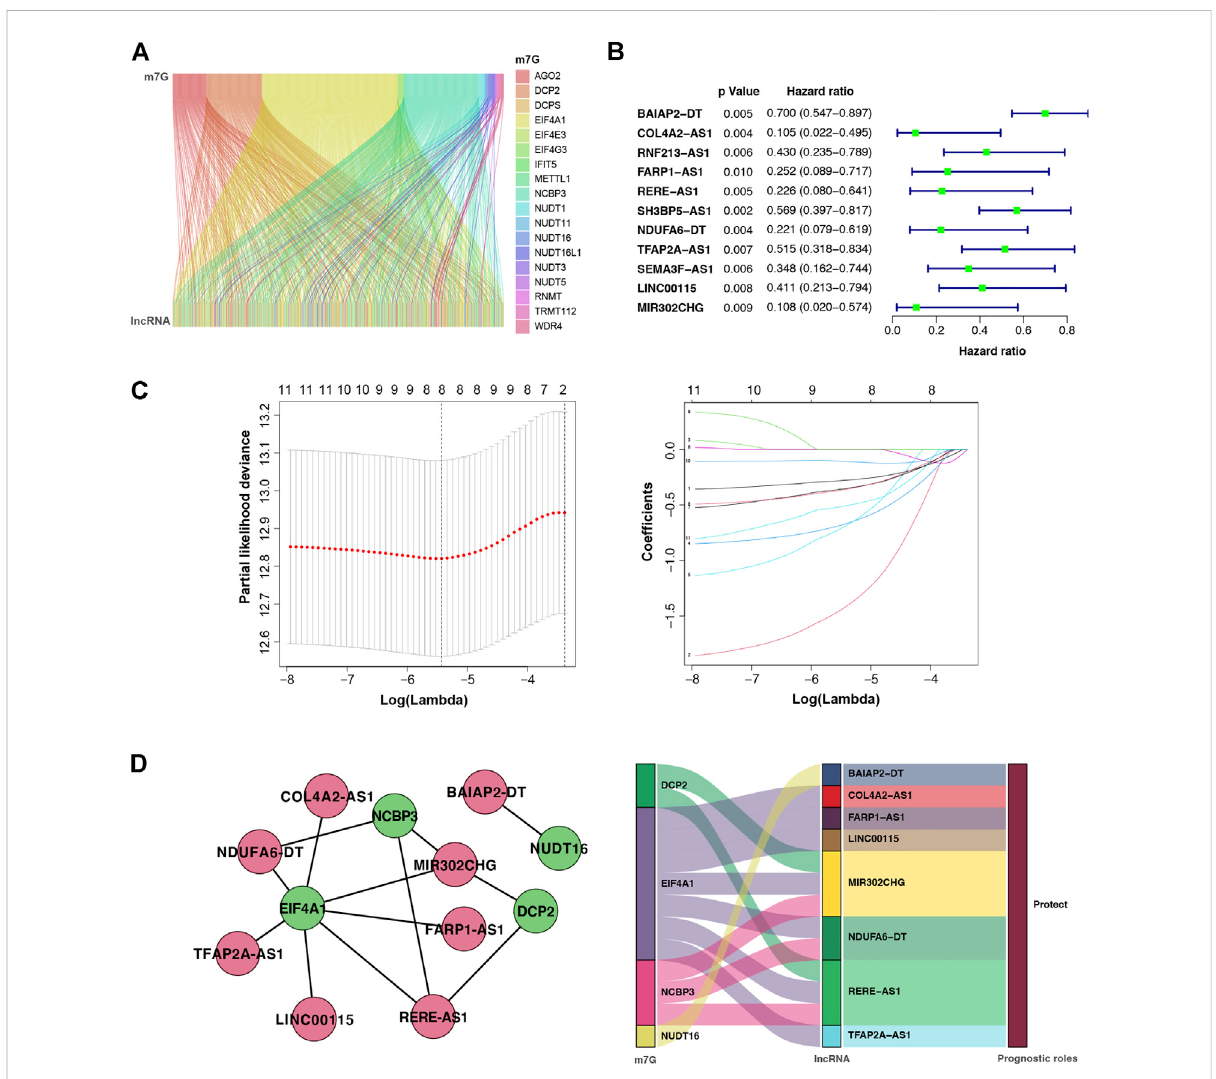
FIGURE 2 m7G-associated lncRNAs (m7G-lncRNAs) and their co-expression networks with signi fi cant prognostic value in breast cancer. (A) Sankey plot showing the relationship between m7G and m7G-lncRNAs. (B) Forest diagram of univariate Cox regression analysis of m7G-lncRNAs. (C) A LASSO Cox regression was used to select independent factors and construct a prognostic signature. (D) Network and Sankey plot showing the connection of m7G and eight m7G-lncRNAs with independent prognostic